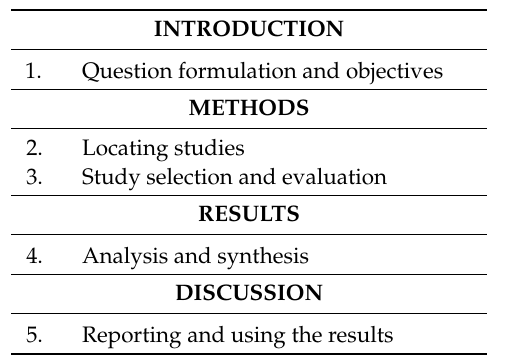
Table 1. Stages proposed in the systematic literature review following the PRISMA